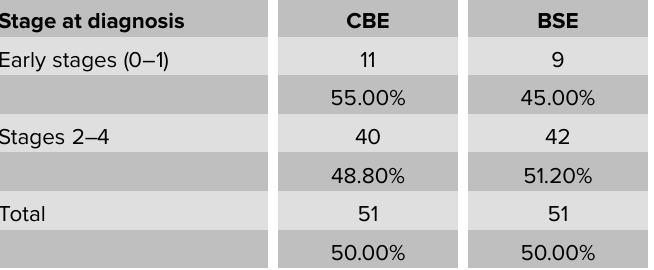
Table 1: The stage at diagnosis according to the detection